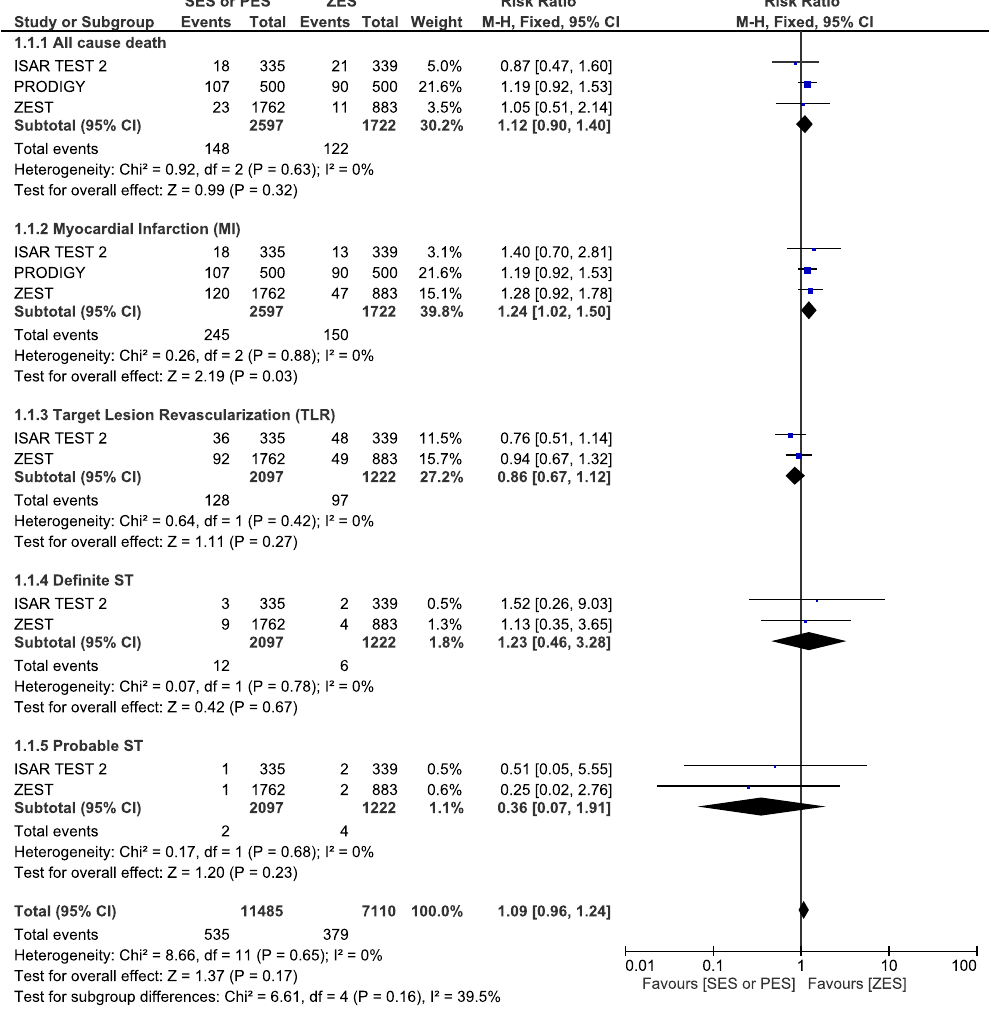
Figure 9. Adverse clinical outcomes which were associated with ZES versus SES or PES at 2-year follow-up (part